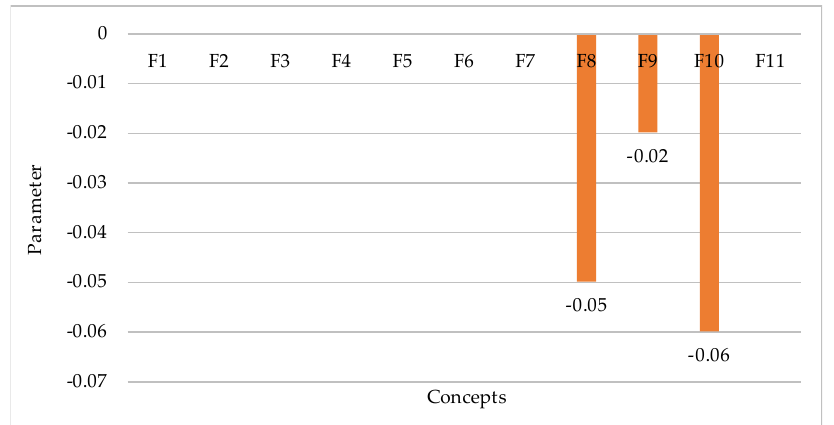
Figure 3. Scenario demonstrating the system response to the most negative changes in the concept F4—malware.